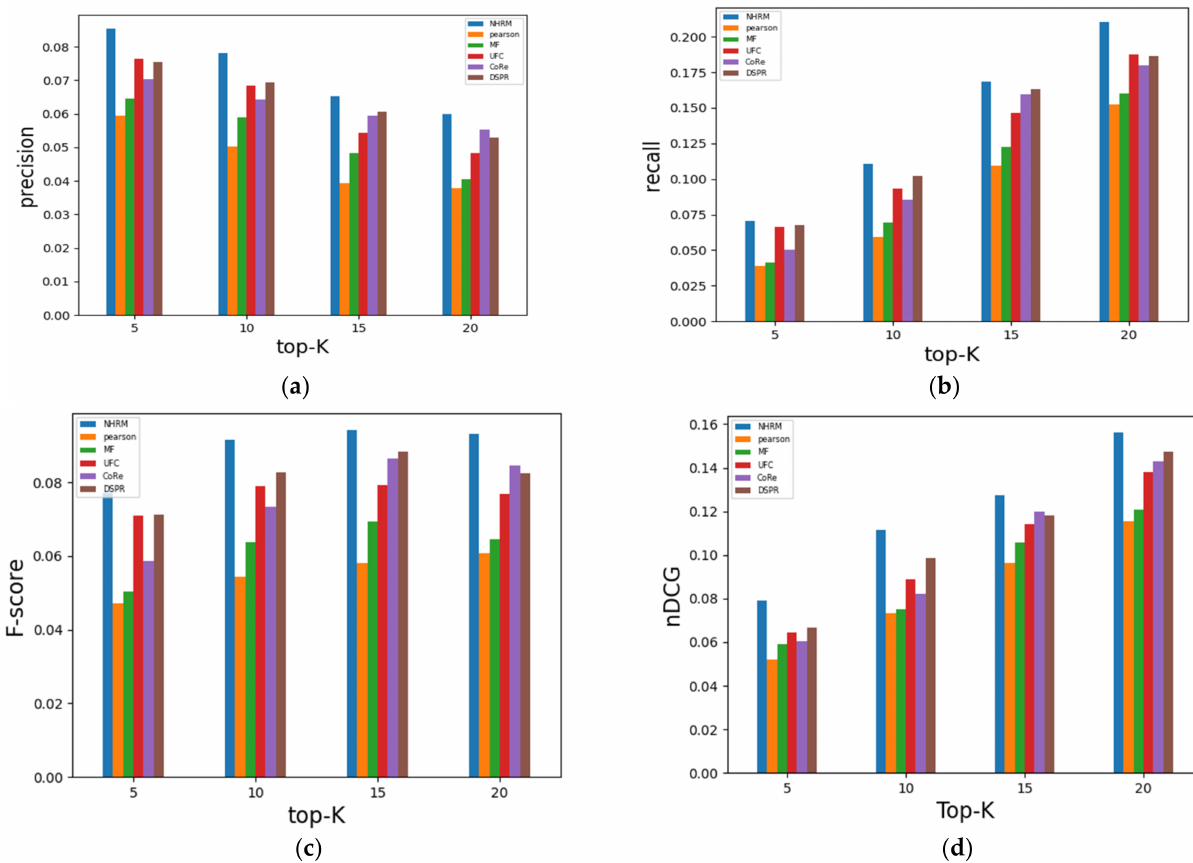
Figure 3. Comparison of results on the Yelp data set. ( a ) comparison of Precision of each method on Yelp data set. ( b ) comparison of Recall of each method on Yelp data set. ( c ) comparison of F-score of each method on Yelp data set. ( d ) comparison of nDCG of each method on Yelp data